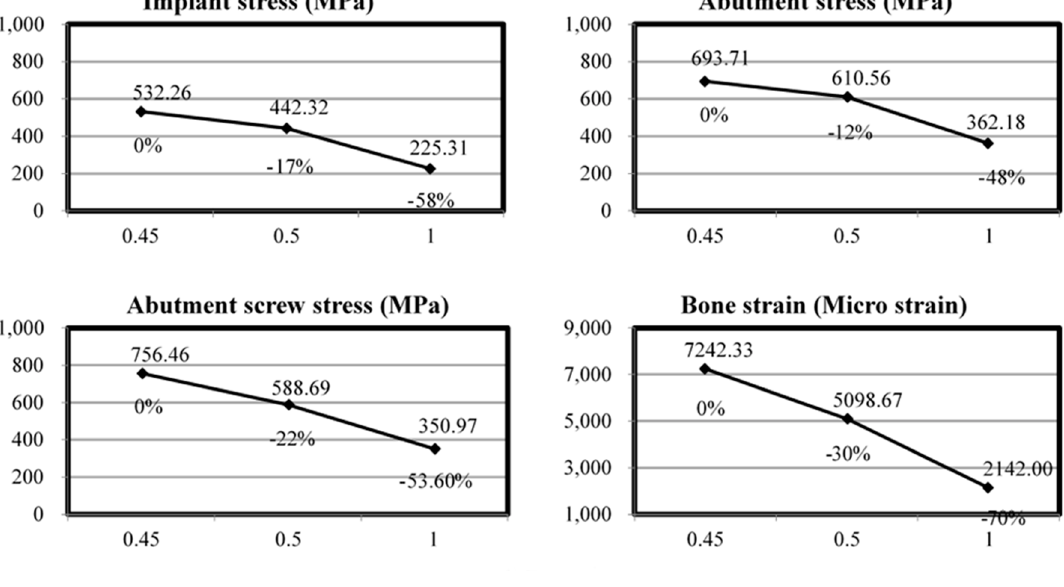
( b ) Figure 2. Main effect plots of implant neck wall ( a ) and abutment screw size at each level for maximum implant, abutment, and abutment screw stresses and maximum bone strain ( b ).